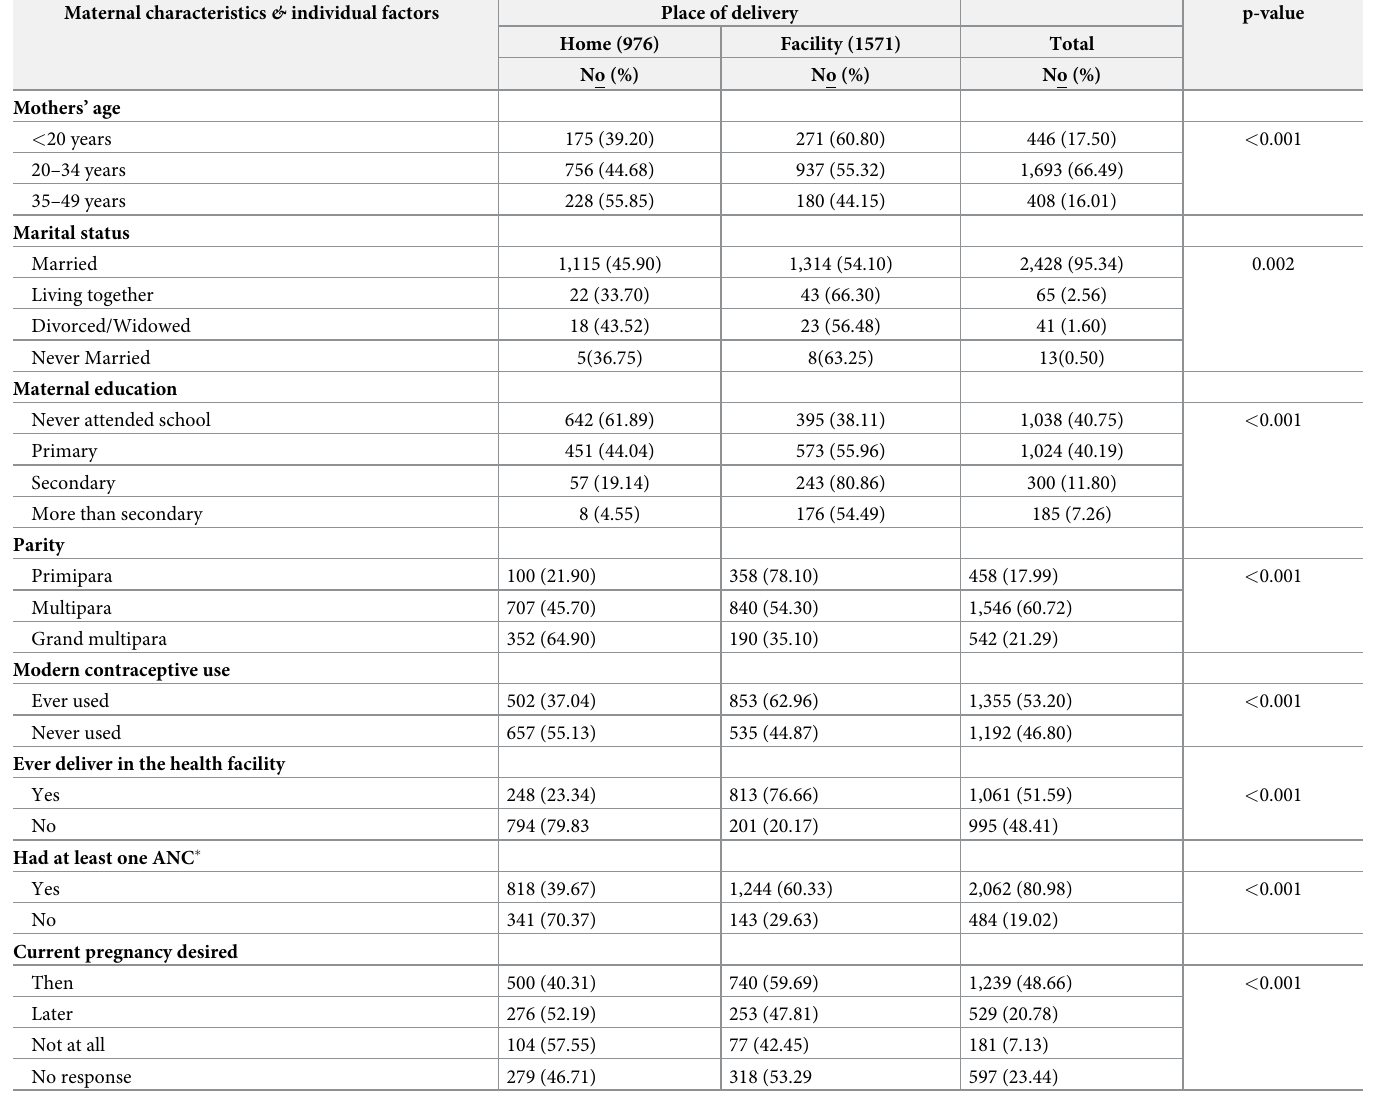
Table 1. Description of individual factors by place of delivery, PMA-Ethiopia 2019. Maternal characteristics & individual